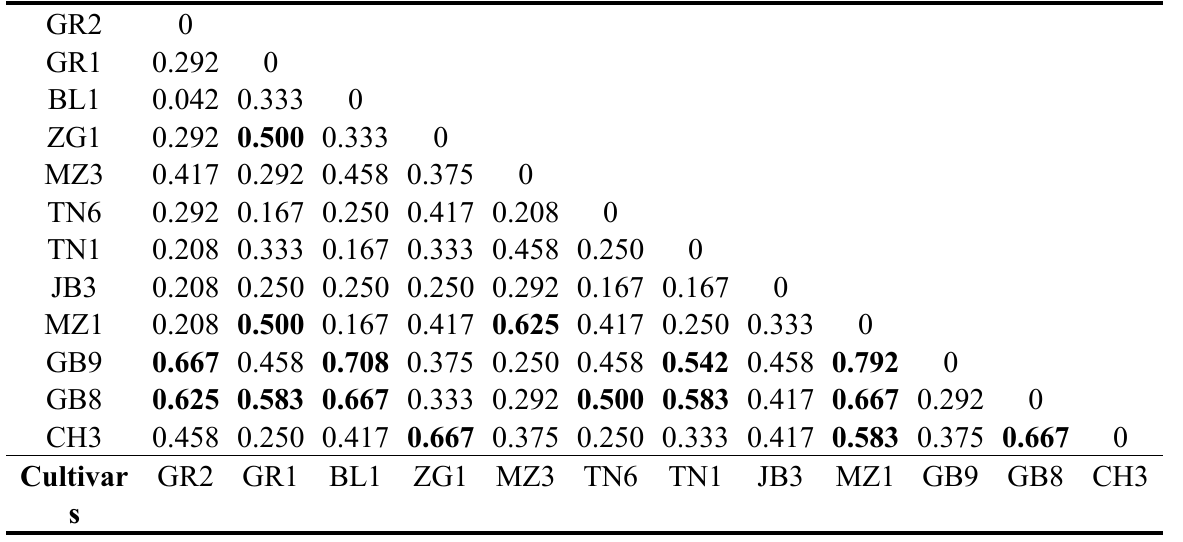
Table 2. Genetic distances calculated on their RAPD